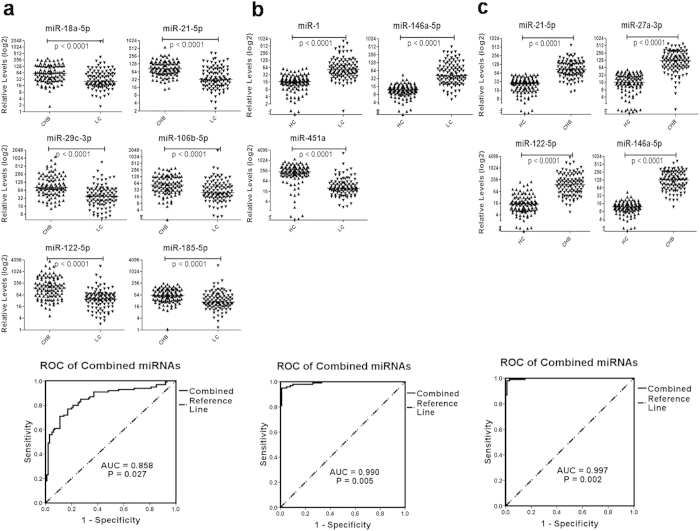
Expression of miRNAs among study subjects in the validation phase.Relative expression levels of the miRNAs in plasma and ROC analysis with combined miRNA panel between LC and CHB patients (a), LC patients and HC (b), and CHB patients and HC (c) in validation phase. P values were calculated using the Mann-Whitney test and p were all <0.01. Logistic regression indicates a linear combination of miRNAs.